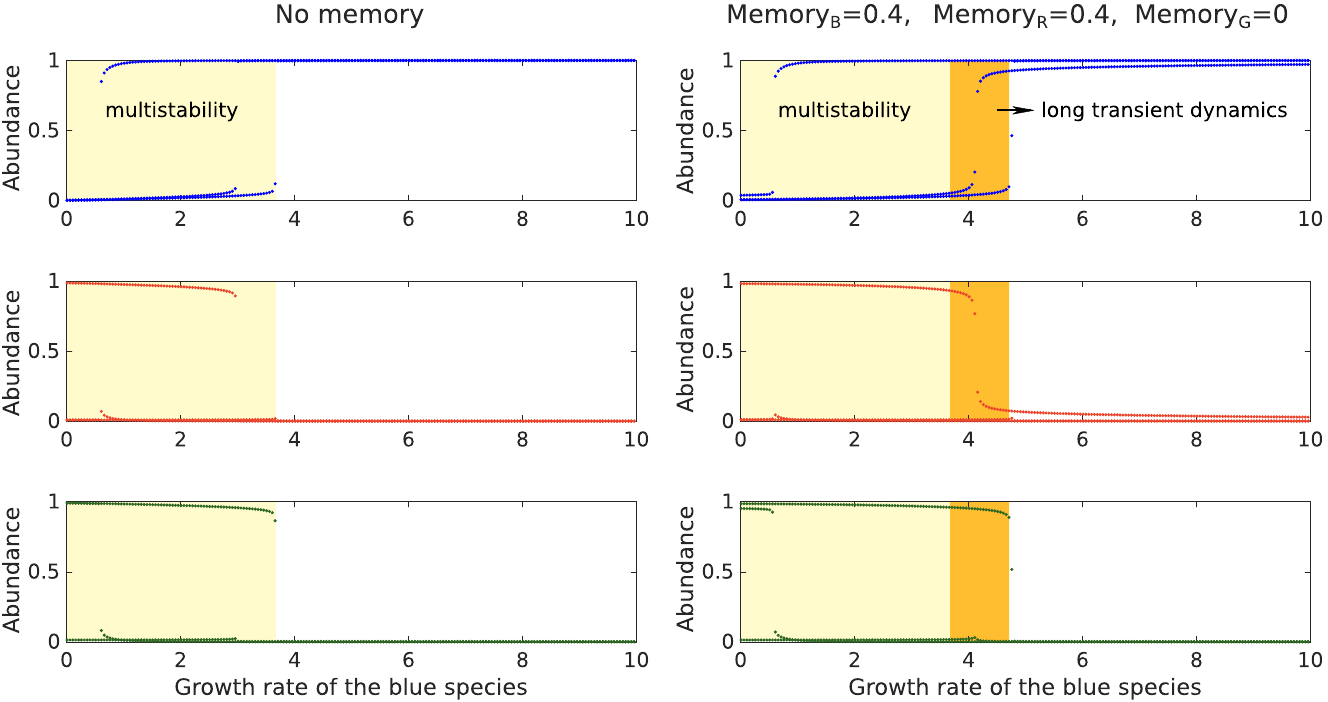
Fig 6. Memory induces long transient dynamics in a region of the parameter space adjacent to the multistable region. Bifurcation diagrams for the 3-species Gonze model showing the relative abundances at time 1,000 of the blue, red, and green species as functions of the blue species’ growth rate, for three different initial conditions (leading to three distinct curves per plot), and in the absence (left column) or presence (right column) of memory. The light and dark yellow regions exhibit several alternative states for the same parameter values. However, it can be shown analytically that the system only admits a single stable state in the dark yellow region, whereas it admits multiple stable states in the light yellow region. Therefore, alternative states at time 1,000 in the dark yellow region correspond to instances of long transient dynamics, where the system remains stuck near ghost attractor states. See S4 Fig for illustrations of the dynamics in the dark yellow region.